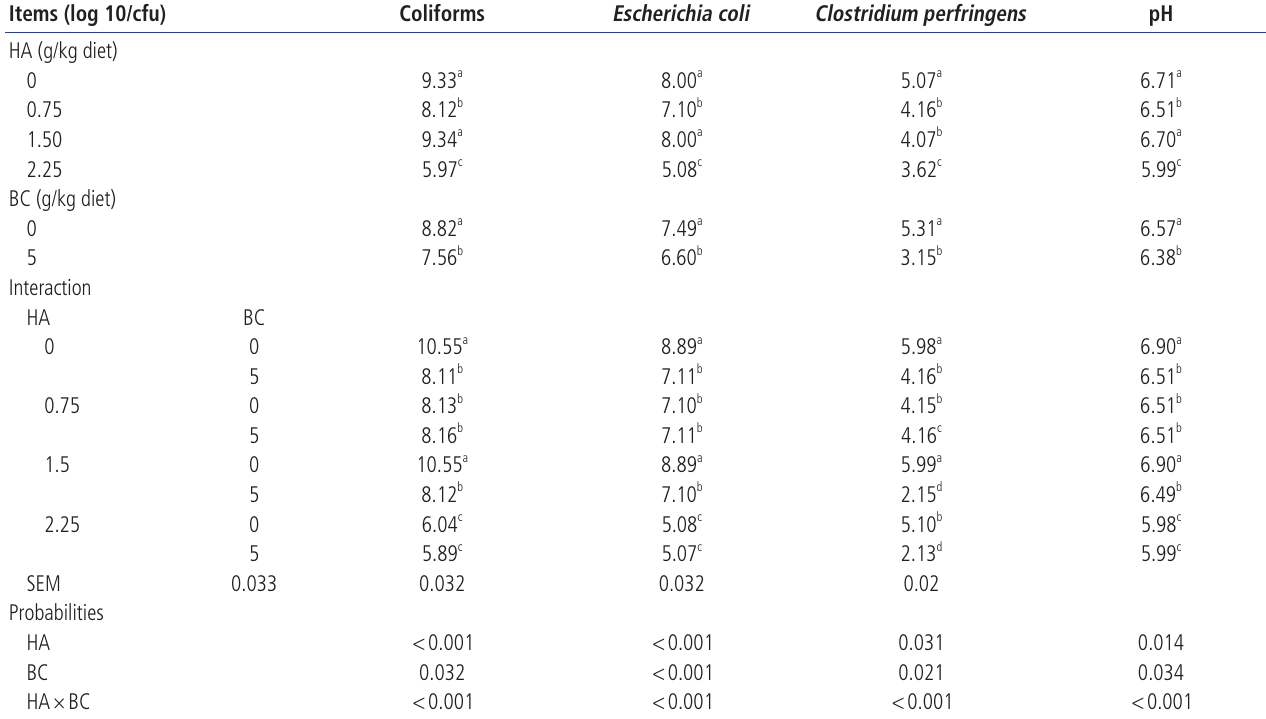
Table 4. Effect of dietary treatments on intestinal microbial count of quail Items (log 10/cfu)